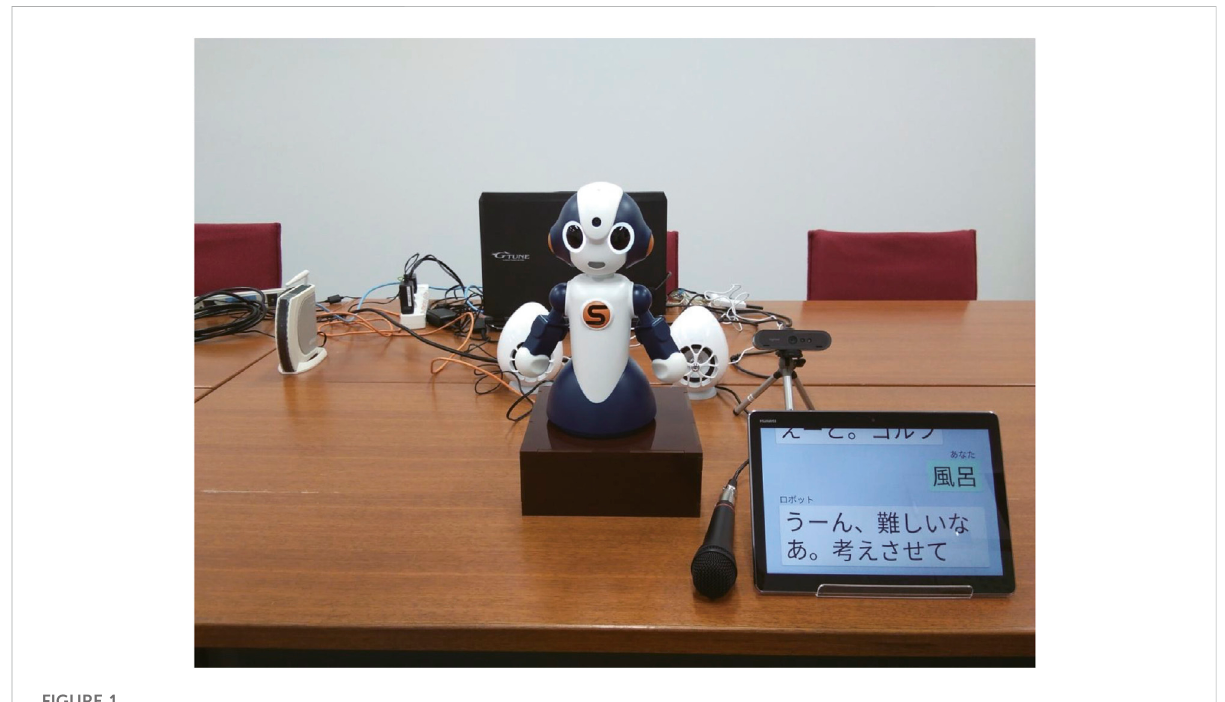
FIGURE 1 Appearance of WOZ